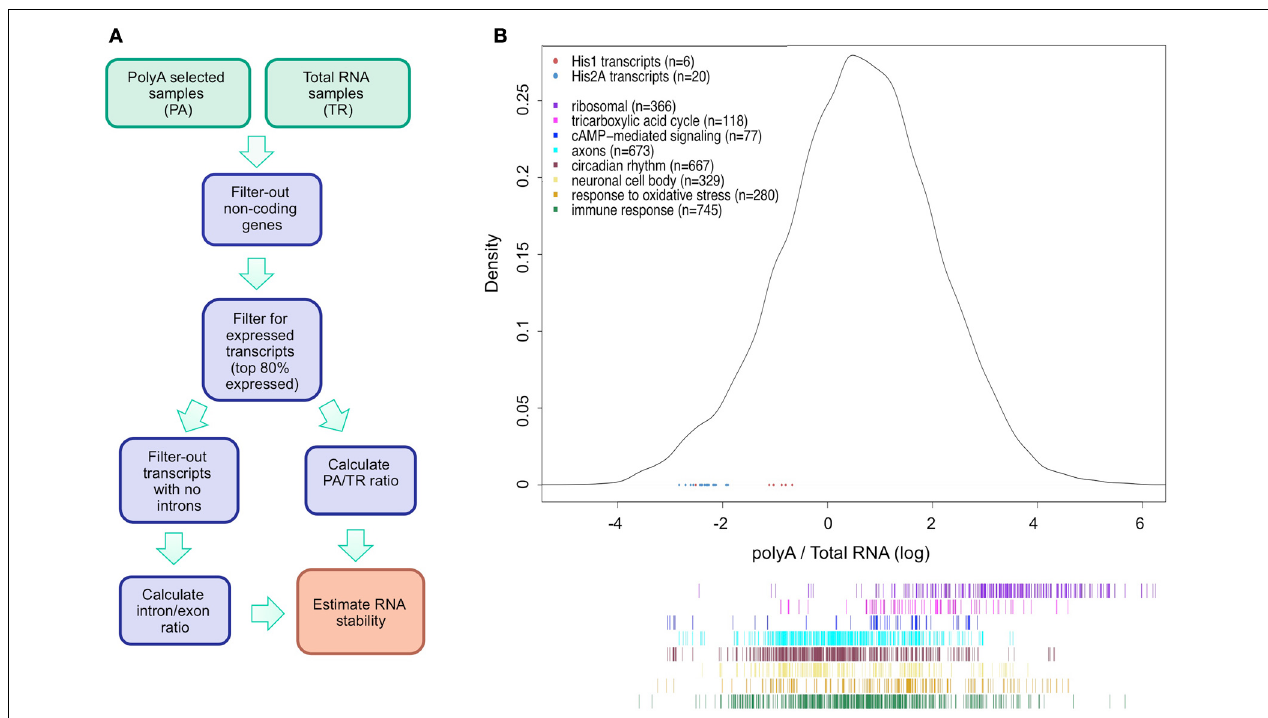
FIGURE 1 | Analysis of mRNA stability using polyA and total RNA-seq data. (A) Schematic illustration of the strategy used to estimate RNA stability. (B) Density plot of the distribution of polyA/total-RNA (PA/TR) values for all transcripts ( n = 32898). Data was log-transformed to achieve normal